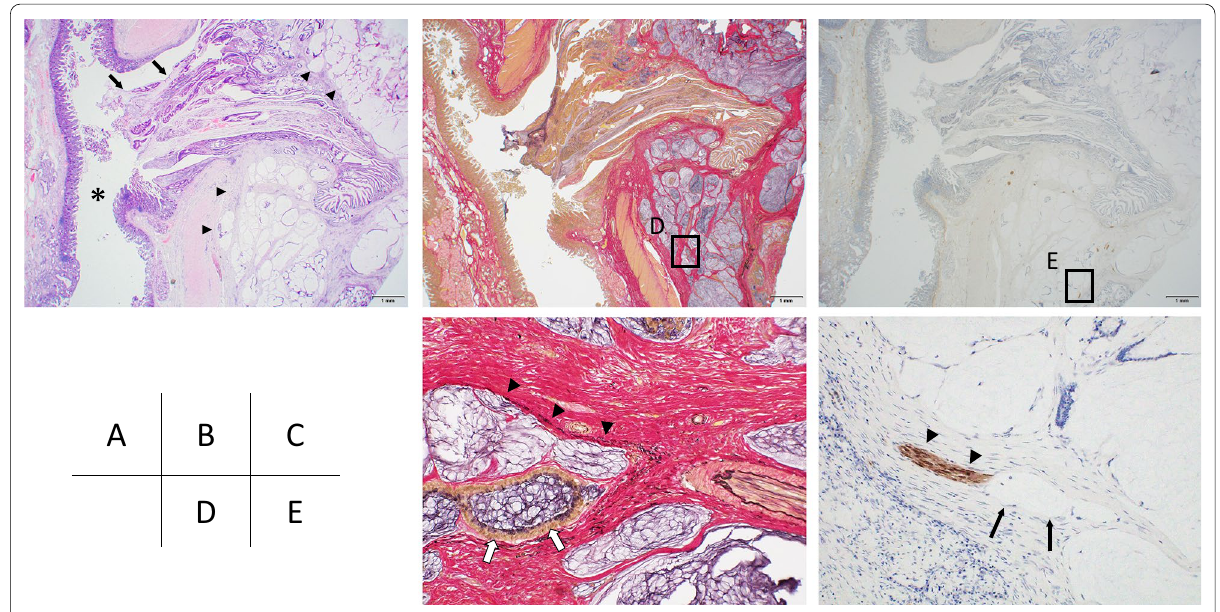
Fig. 5 Elastica van Gieson staining and S-100 immunostaining. The duodenal papillary common channel was investigated with HE staining ( a 12.5), Elastica van Gieson staining ( b 12.5; d 100), and S-100 immunostaining ( c 12.5; e 100). a The IAPN (arrow) pervading in the × × × × × common channel (asterisk) was transformed to the mucinous adenocarcinoma which invaded to the stroma of Vater papilla extensively (arrowhead). d Elastica van Gieson staining (high-magnification image of square in b ) showed cancer cells (arrow) inside elastic tissues in the vein wall (arrowhead), indicating venous invasion. e S-100 immunostaining (high-magnification image of square in c ) showed mucous nodes (arrow), adjacent to a nerve fiber bundle (arrowhead), indicating perineural infiltration